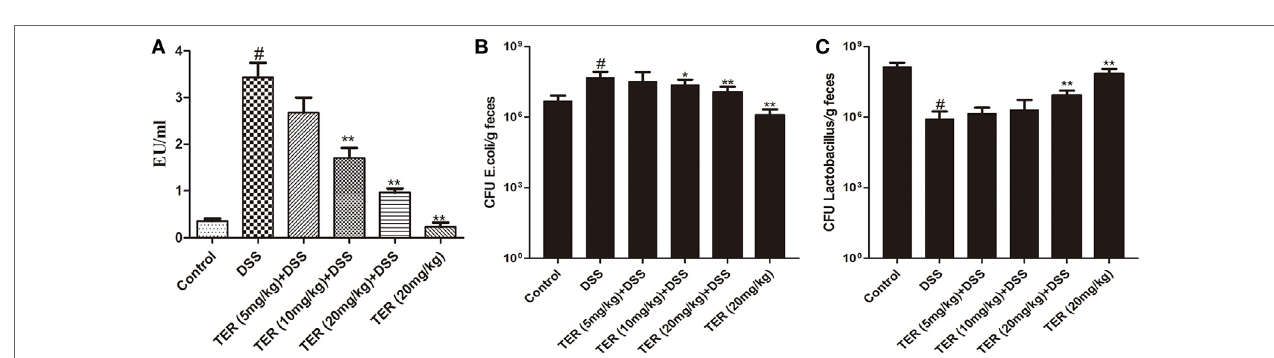
FigUre 6 | Terpinen-4-ol (Ter) decreases plasmatic lipopolysaccharide (lPs) concentrations and re-balance E. coli and Lactobacillus . (a) The plasmatic LPS concentrations were measured by Limulus amebocyte lysate assay. (B) E. coli and (c) Lactobacillus were detected by quantitative real-time PCR. Data are presented as means ± SD ( n = 9). * p < 0.05 and ** p < 0.01 vs the group treated with only dextran sulfate sodium (DSS); # p < 0.05 vs control